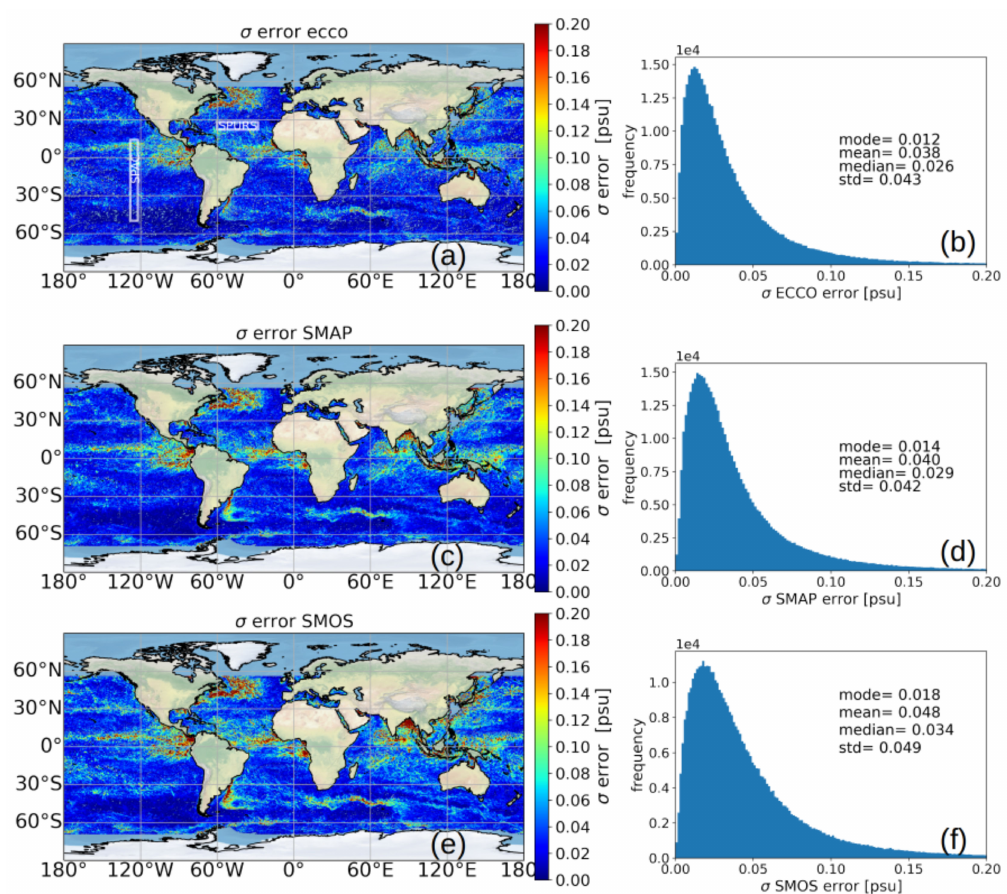
Figure 8. Maps of the error standard deviation ( left column ) and its associated histogram ( right column ) of the ecco model ( a , b ) simulated SSS satellite for SMAP ( c , d ) and SMOS ( e , f ). White solid lines in panel ( a ) delimit the regions considered to compute the spectral analysis of SSS shown in Figure